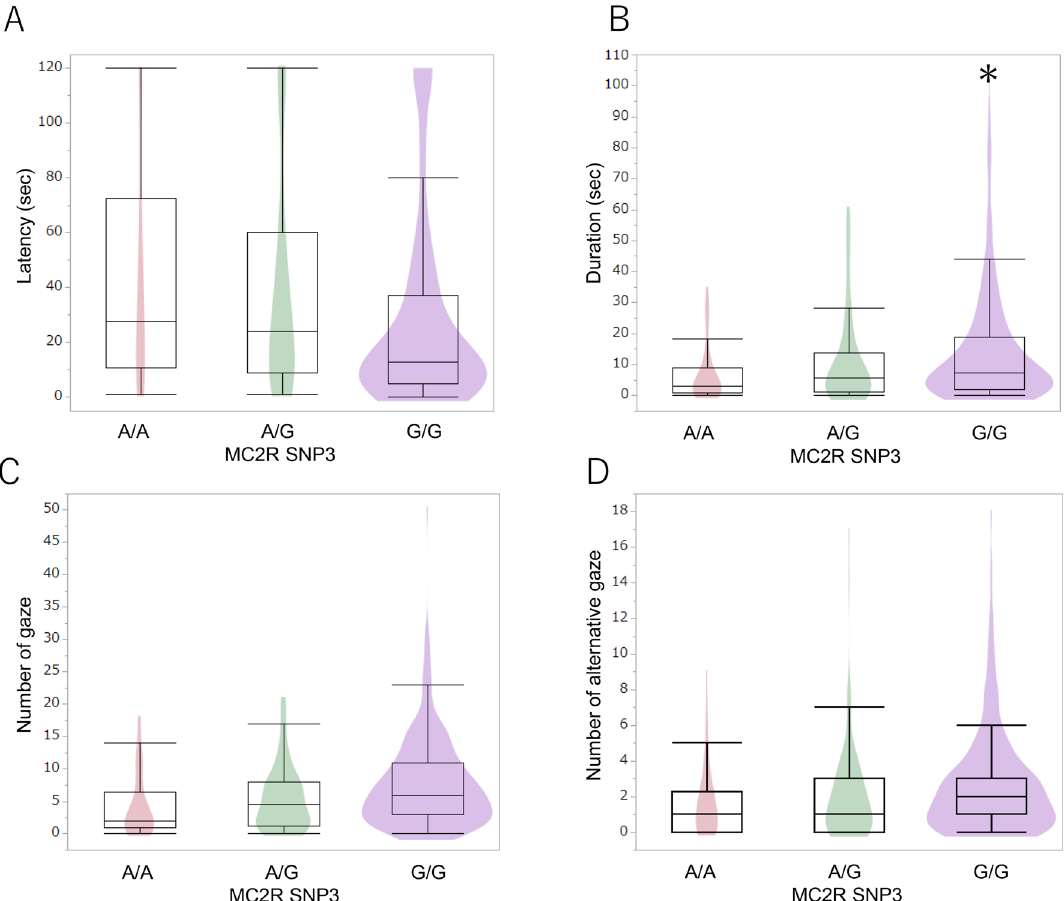
Figure 4. Allelic comparisons of MC2R SNP3 polymorphisms in the problem-solving test. Dogs with the G/G allele looked back at the experimenters for longer durations than dogs with the A/G and A/A alleles (B). * p < 0.05 (GLM followed by Bonferroni post-hoc